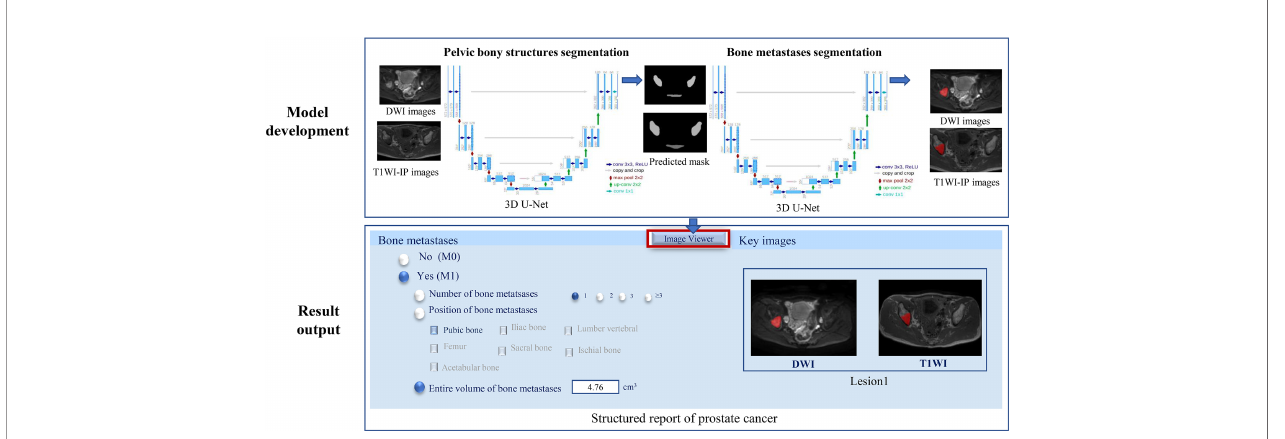
FIGURE 2 | Thetwo-step3DU-Netfor bone metastasessegmentationonDWIandT1WI-IPimages.T1WI-IP,